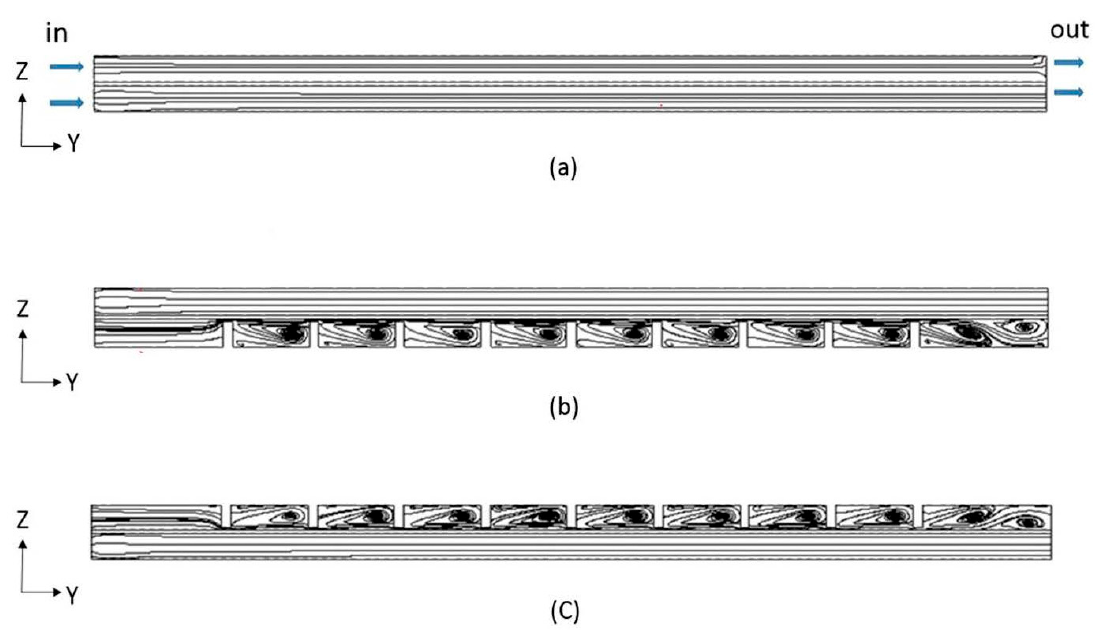
Figure 11. The flow field variation of flow channel for ( a ) the smooth-channel, ( b ) first channel for positive electrode, and ( c ) first channel for negative electrode with nine baffles from numerical anal- ysis.